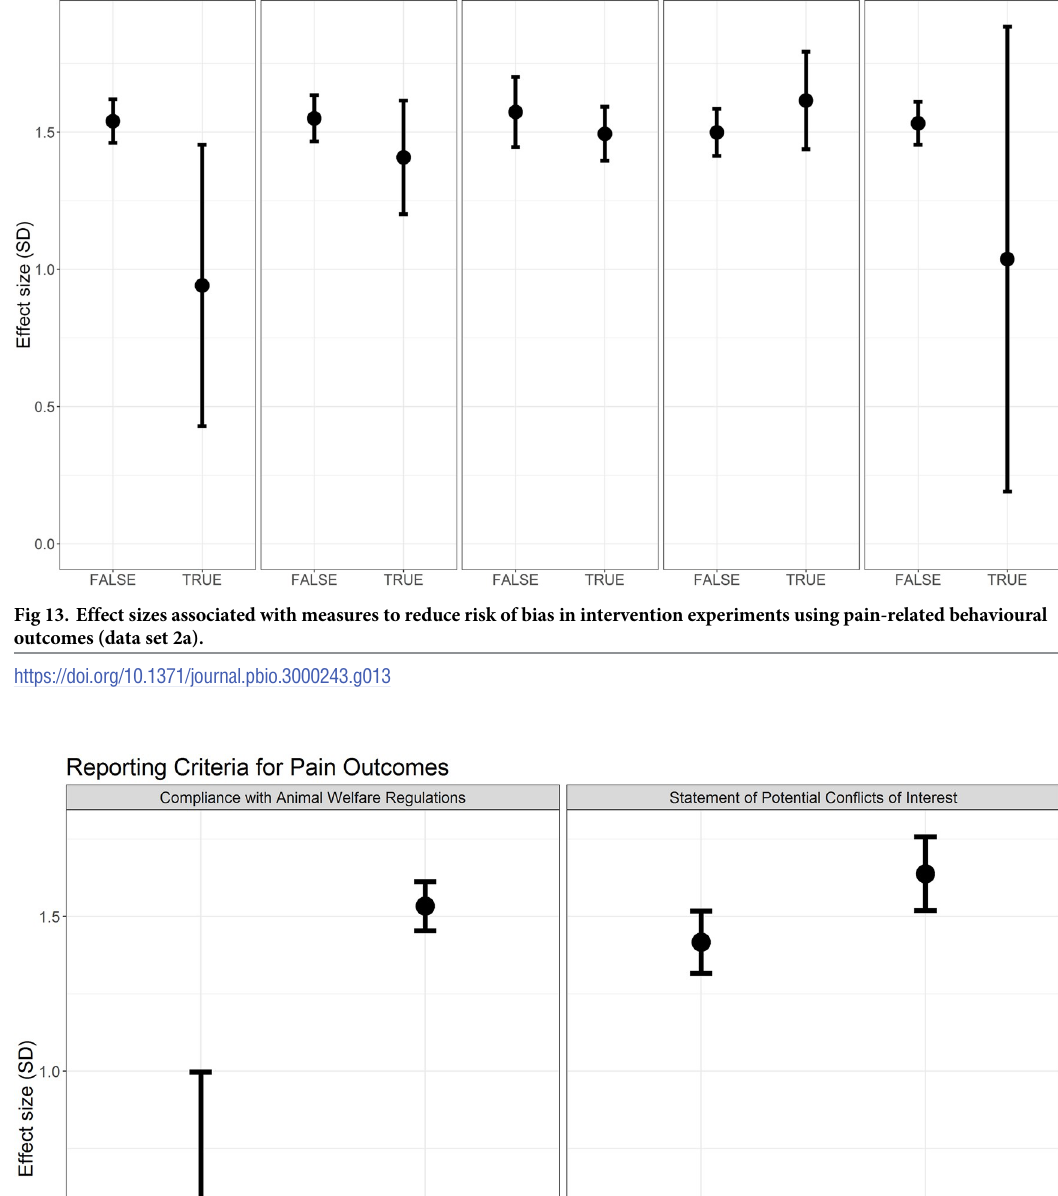
PLOS Biology | https://doi.org/10.1371/journal.pbio.3000243 May 20,